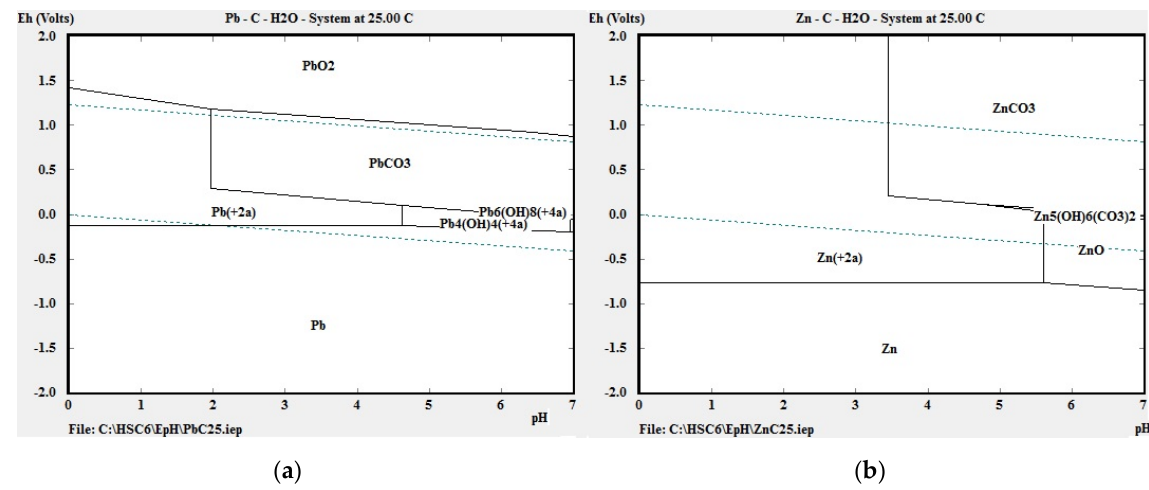
Figure 3. E-pH diagrams of systems ( a ) Pb-C-H 2 O and ( b ) Zn-C-H 2 O at 298 K, created with HSC Chemistry software, ver. 6 (Outotec, Espoo, Finland).